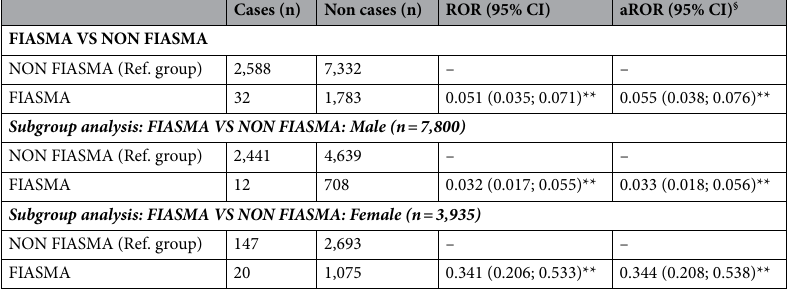
Cases (n) Non cases (n) ROR (95% CI) aROR (95% CI) § FIASMA VS NON FIASMA